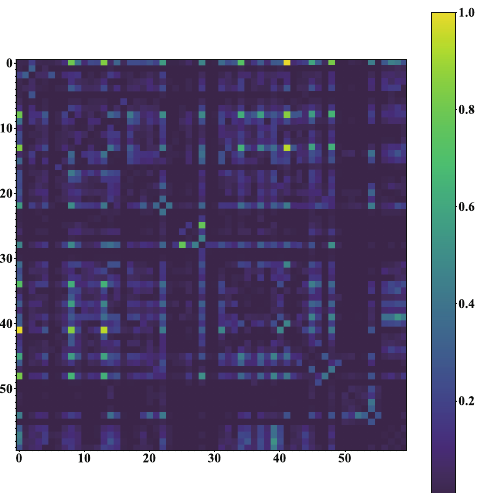
Figure 4. The graph representation of the semantic airport network is built up by the flight